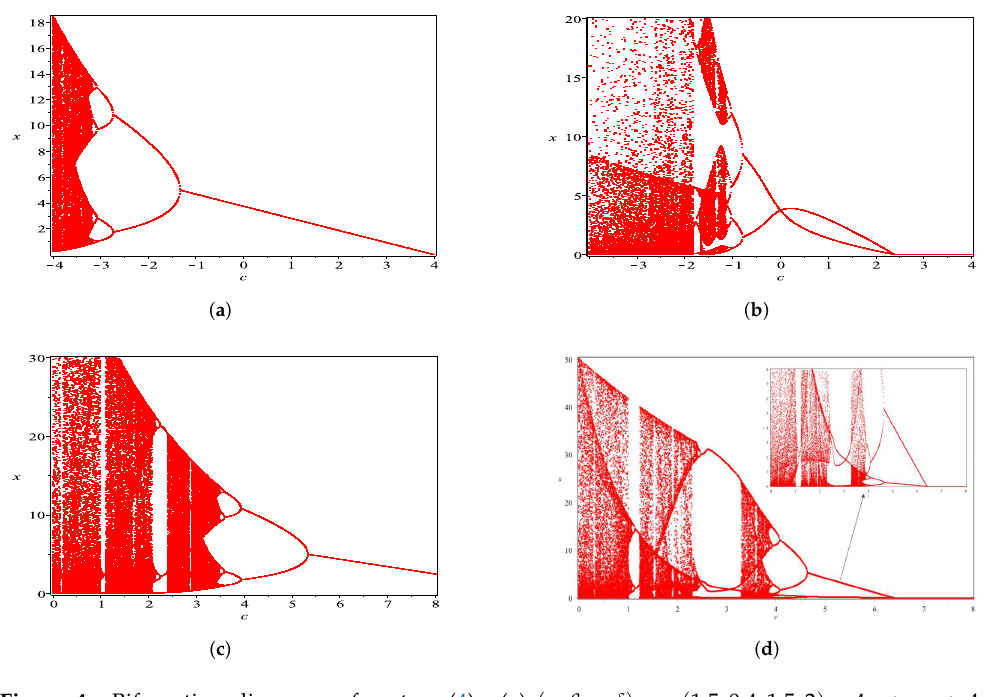
Figure 4. Bifurcation diagrams of system (4). ( a ) ( α , β , γ , δ ) = ( 1.5,0.4,1.5,2 ) , − 4 < c < 4; ( b ) ( α , β , γ , δ ) = ( 1.5,0.4,2.5,2 ) , − 4 < c < 4; ( c ) ( α , β , γ , δ ) = ( 4,0.4,1.5,2 ) ,0 < c < 8; ( d ) ( α , β , γ , δ ) = ( 4,0.4,2.5,2 ) ,0 < c <